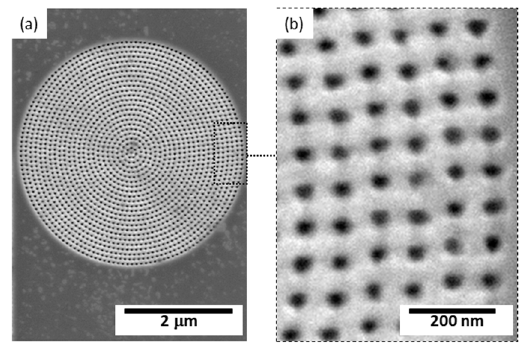
Figure 4. ( a ) Illustration of the speckle applied before full FIB machining and ( b ) a detailed view of the pattern.